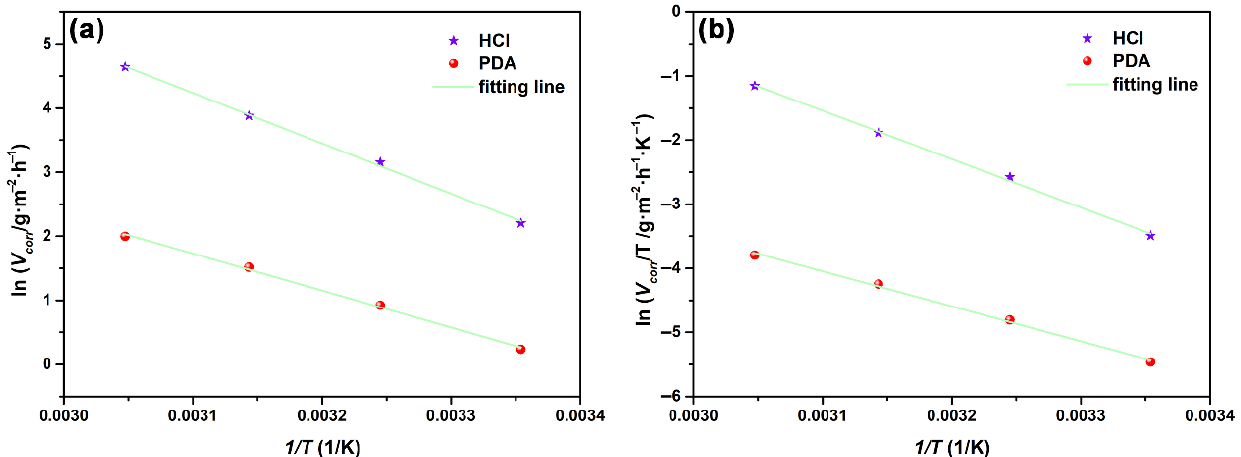
Figure 10. The plots of ( a ) ln V corr versus 1/ T and ( b ) ln V corr versus 1/ T for steel exposed to 1 M HCl in the absence and presence of 400 ppm NCDs. Table 4. The activation parameters for Q235 carbon steel in 1 M HCl in the absence and presence of 400 ppm NCDs.